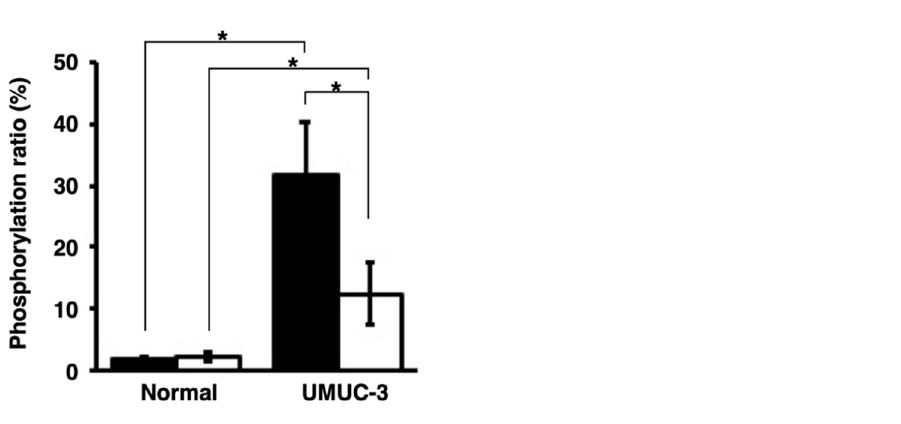
Figure 5. Detection of activated PKC α in the urine samples collected from orthotopic xenograft mice with UMUC-3 and normal mice (n = 3). The phosphorylation ratios were calculated after phosphorylation of the PKC α -specific peptide with the urine sediments (black bars) or urine supernatants (white bars). * p < 0.01.